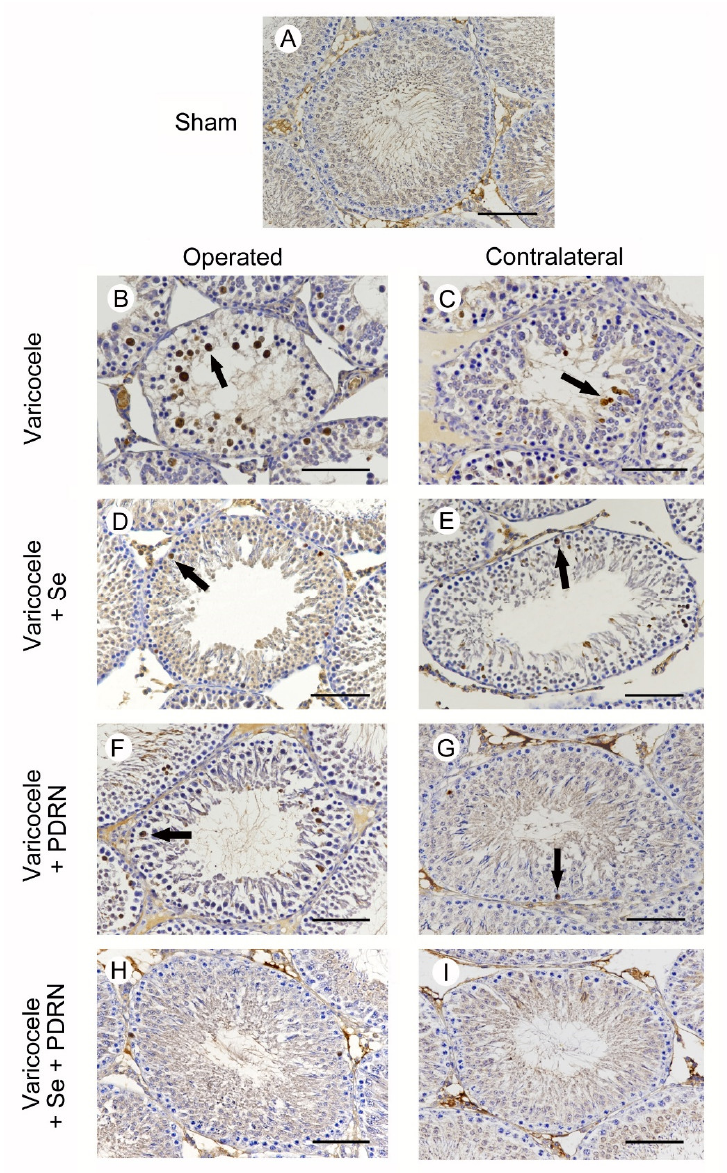
Figure 5. Immunohistochemical localization of caspase-1 in the testes from rats of sham, varicocele, varicocele contralateral, varicocele plus Se (0.4 mg/kg/day i.p.), varicocele plus Se contralateral, varicocele plus PDRN (8 mg/kg/day i.p.), varicocele contralateral plus PDRN, varicocele plus Se plus PDRN, varicocele contralateral plus Se plus PDRN groups. ( A ): In sham rats, no caspase-1 positive cells can be observed. ( B ): In varicocele rats, a large number of caspase-1 positive cells are located in the wall of the tubules (arrow). ( C ): In the contralateral testes of the same rats, some isolated caspase-1 positive cells are present (arrow). ( D ): In varicocele rats treated with Se, many caspase-1 positive cells are present in the periphery of the seminiferous tubules (arrow). ( E ): In the contralateral testes of the same group, some caspase-1 positive cells are located in the external part of the tubules (arrow). ( F ): In the testes of varicocele rats treated with PDRN, fewer caspase-1 positive cells are located along the periphery of the tubules (arrow). ( G ): In contralateral testes of the same group, only isolated caspase-1 positive cells (arrow) are present. ( H , I ): In the seminiferous tubules of both operated and contralateral testes of varicocele rats treated with Se plus PDRN, very rare or no caspase-1 positive cells are demonstrated. (Scale bar: 50 µ